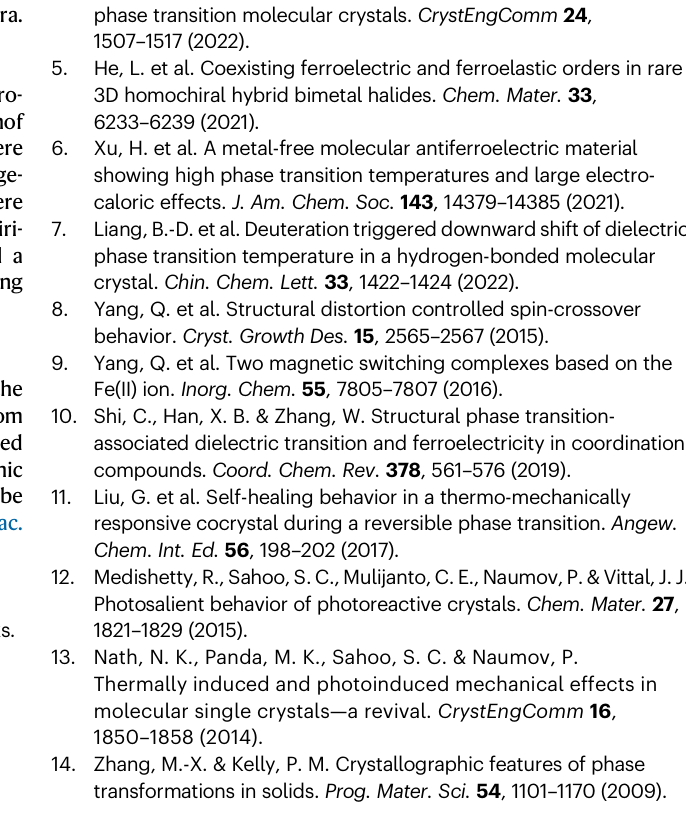
Fig. 7 | Semiconductor-related properties of 1. a UV − vis absorption spectrum. Inset: Fitted bandgap from the absorption spectrum. b DFT-PBE band structures without SOC and c DOS. d Partial charge density of the VBM and CBM. Yellow isosurface is electron cloud distribution. e I − V curves of the photodetector upon a